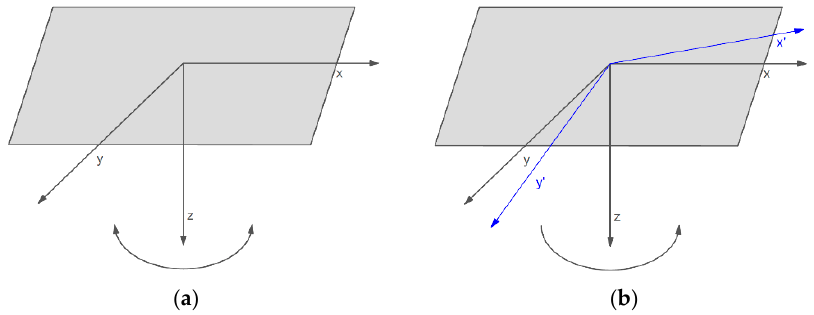
Figure 8. The rotational events recorded by FOSREMs: ( a ) torsion, ( b ) tilt.